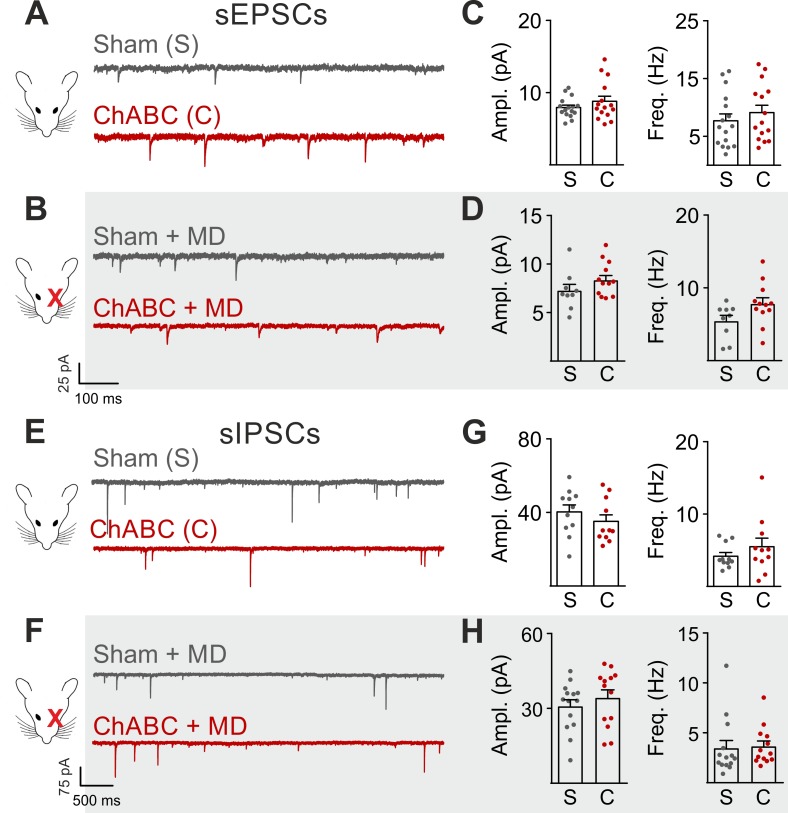
Glutamatergic and GABAergic synaptic transmission onto PNs are unaffected by PNN degradation.(A–B) Example voltage-clamp traces of sEPSCs recorded in absence (A) and presence (B) of MD, in control animals (Sham, grey) and after ChABC treatment (ChABC, red). (C–D) Plots of average sEPSC amplitude (left) and frequency (right), in absence of MD (c) and in monocular-deprived animals (D), in control animals (S, grey) and after PNN removal (C, red). (E–H) Same as in (A–D), but for sIPSCs, pharmacologically isolated in presence of the glutamate receptor antagonist DNQX. All values are in Supplementary Tables 3 and 5.
10.7554/eLife.41520.013Figure 2—figure supplement 4—source data 1.Source data for Figure 2—figure supplement 4C,D,G,H.